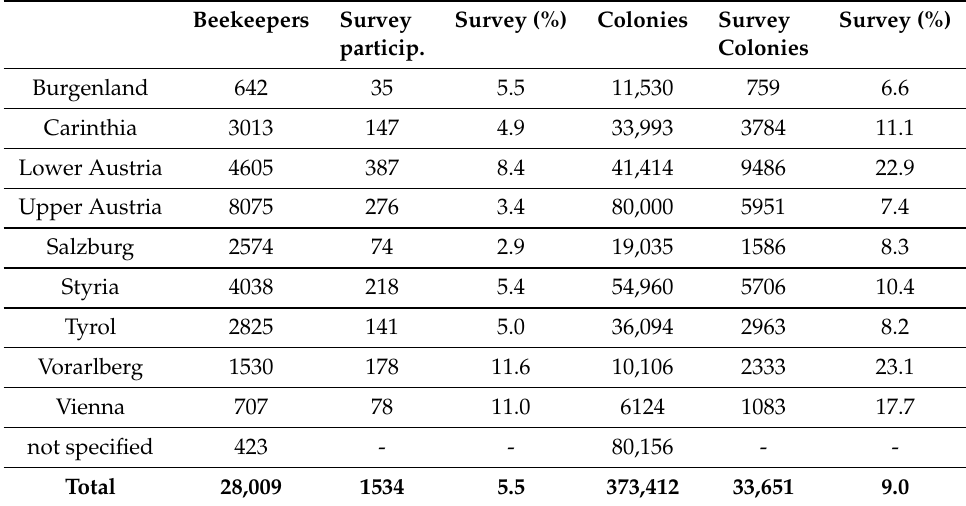
Table 1. Number and percentage of survey participants in relation to the amount of registered beekeepers with the national beekeeping association “Biene Österreich” (2018): Commercial beekeepers are subsumed as “not specified” due to the absence of state